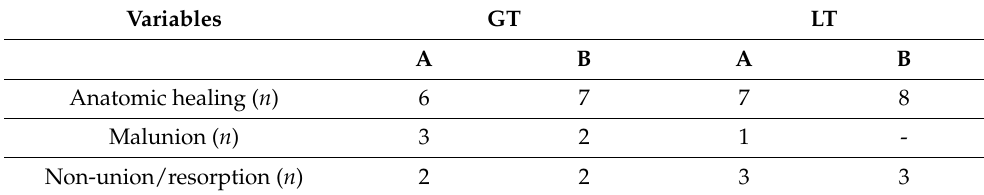
Table 3. Descriptive table with quality of GT and LT healing with regards to